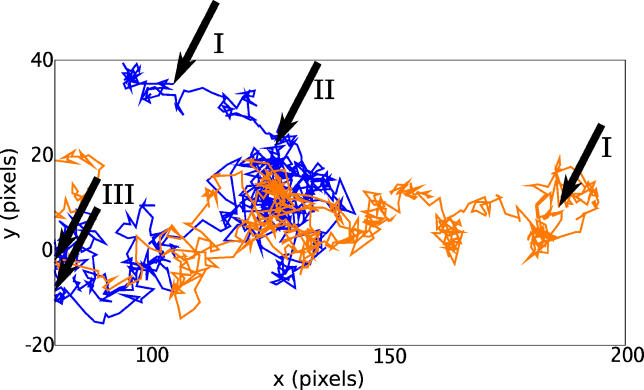
Cell Tracking of Two Individual Dark Cells in a Cell Mass Chemotactically Moving to the RightThe arrows I indicate the initial positions of the cells, the arrows III the final positions. The cell represented by the orange track almost immediately becomes part of a cluster, and slowly moves backward, while the cell represented by the blue track initially moves forward as a single cell, but later on joins a cluster (arrow II), and then moves backward. Jl,l = 5, Jd,l = 6, and Jd,d = 3; other parameters are as in Figure 5. This behaviour is illustrated by Video S6.